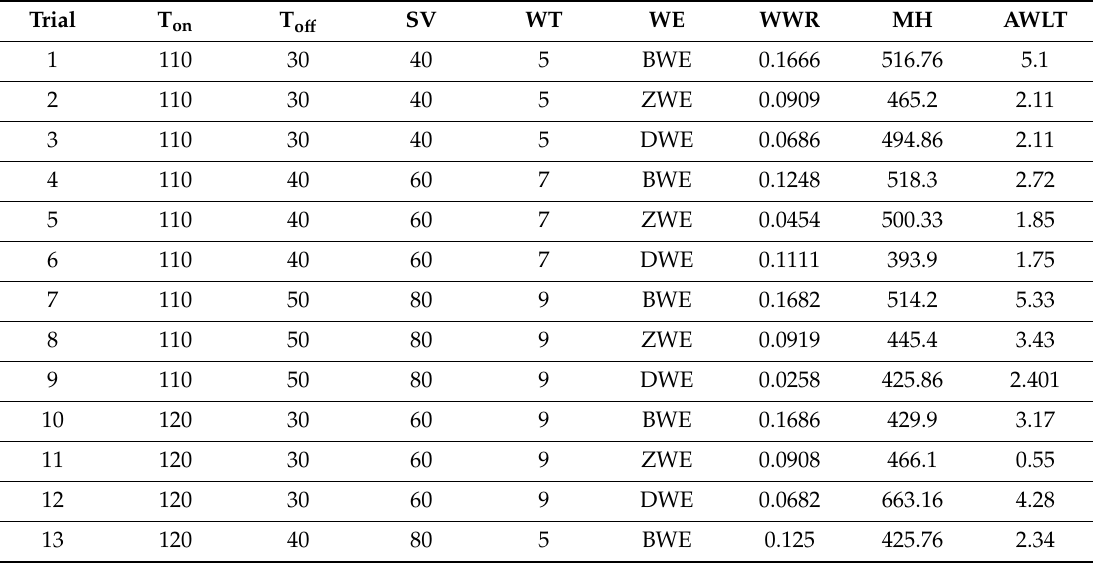
Figure 2. Surface topography of the machined Ti-6Al-4V alloy in WEDM process. Table 2. OA with performance measures.